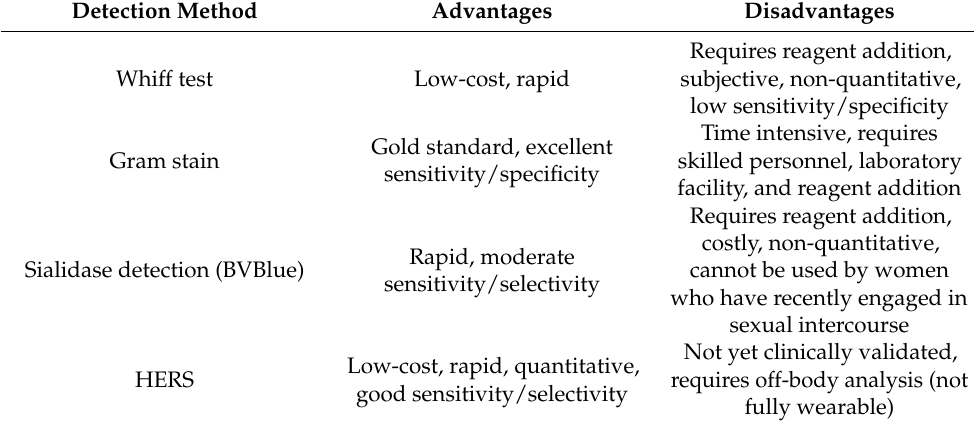
Figure 7. ( A ) The response of the HERS electrodes (n = 5) in sVF (pH = 6.6) to spiked TMA + . ( B ) The response of the HERS electrodes (n = 5) in sVF (pH = 4.0) to spiked TMA + . Highlighted regions correspond to the linear range of 10 µM–100 mM. ( C ) The measured emf of the HERS electrodes (n = 5) before and after spiking with 260 µ M TMACl in the sVF (pH = 6.6 and pH = 4.0). ( D ) The emf trace of the HERS electrodes (n = 5) before and after spiking with 260 µ M and 520 µ M TMACl in the cVF. Table 2. Advantages and disadvantages of the HERS vs. other detection methods